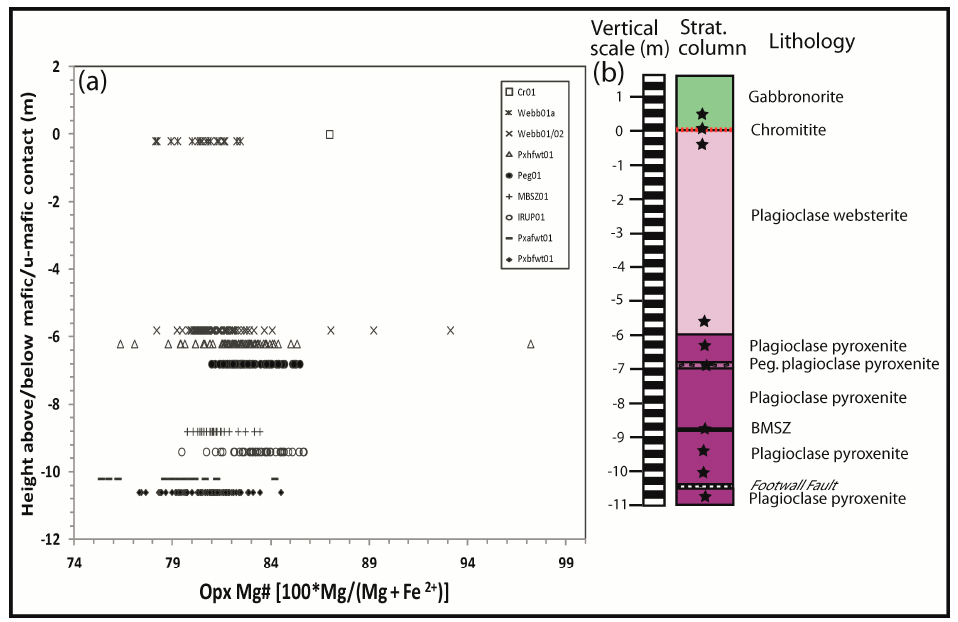
Figure 10. ( a ) Plot of orthopyroxene Mg#s versus stratigraphic height of the MSZ for all orthopyroxene analyses. Corresponding sample locations and lithologies are shown in ( b ).